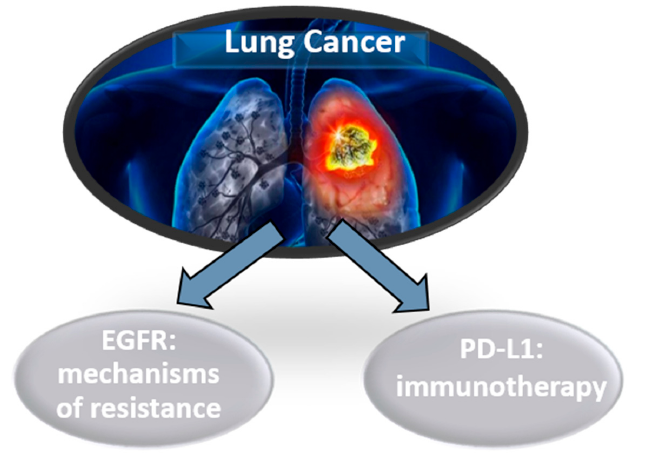
Figure 3. Liquid biopsy’s biomarkers for optimal treatment in lung cancer.